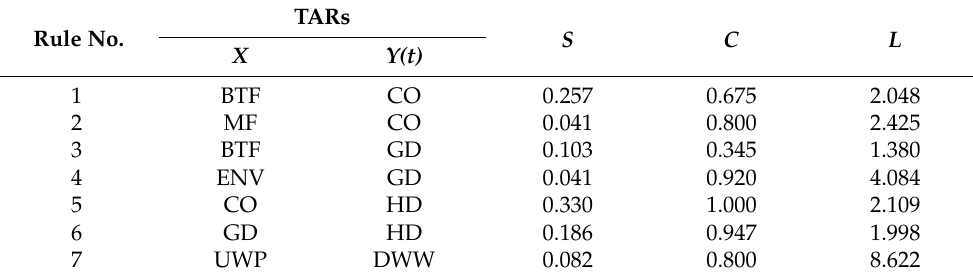
Table 3. TAR results for Ro-Ro ships.